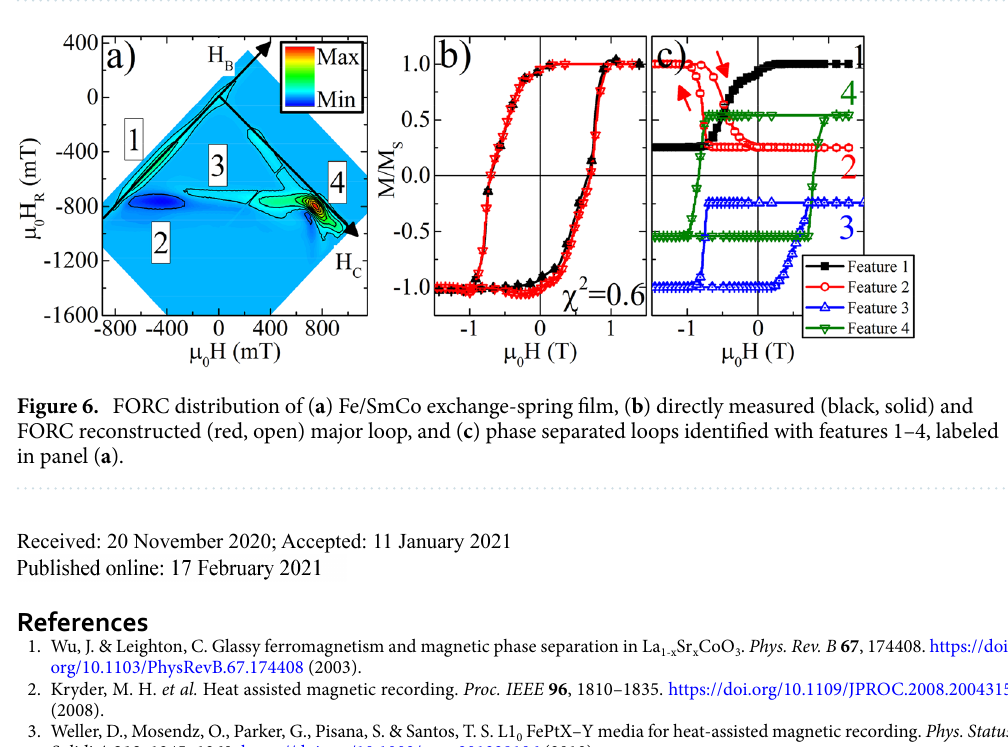
Figure 5. FORC distributions of ( a – c ) 52 nm, 58 nm, and 67 nm diameter Fe nanodots, ( d – f ) directly measured (black, solid) and FORC reconstructed (red, open) major loop, and ( g – i ) phase separated major loops, respectively. The single-domain and vortex features are identified in ( b ) by 1 and 2, respectively. The area selected for reconstructing the single-domain loop for the 58 nm dots is shown as the dashed white box in ( b ).